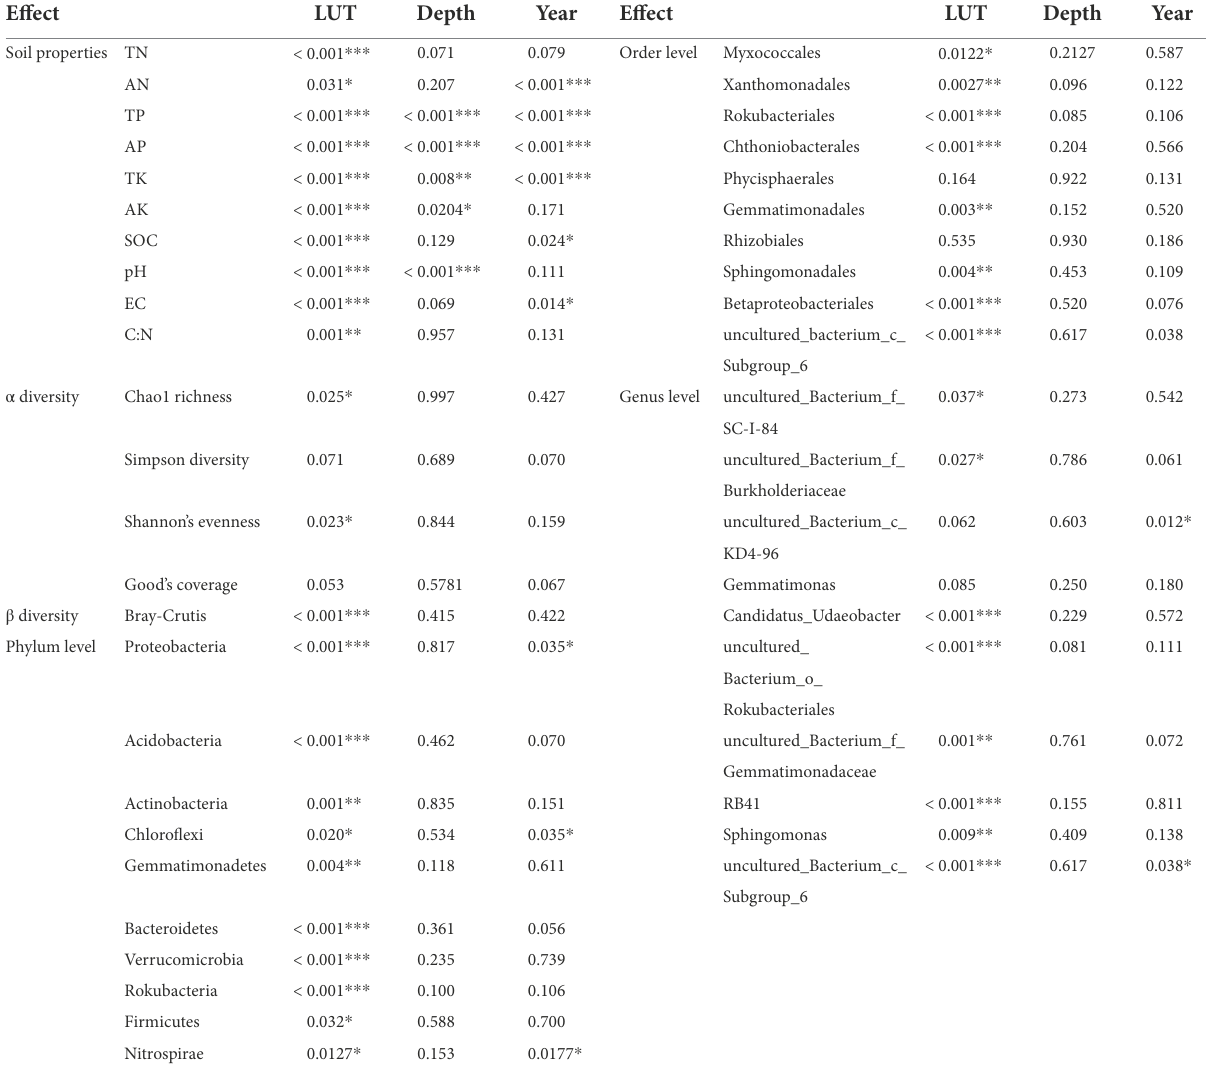
TABLE 1 Anova analysis of the effects of land use type (LUT), soil depth (Depth) and cultivated land years (Year) on soil properties and bacterial diversity and relative abundance.